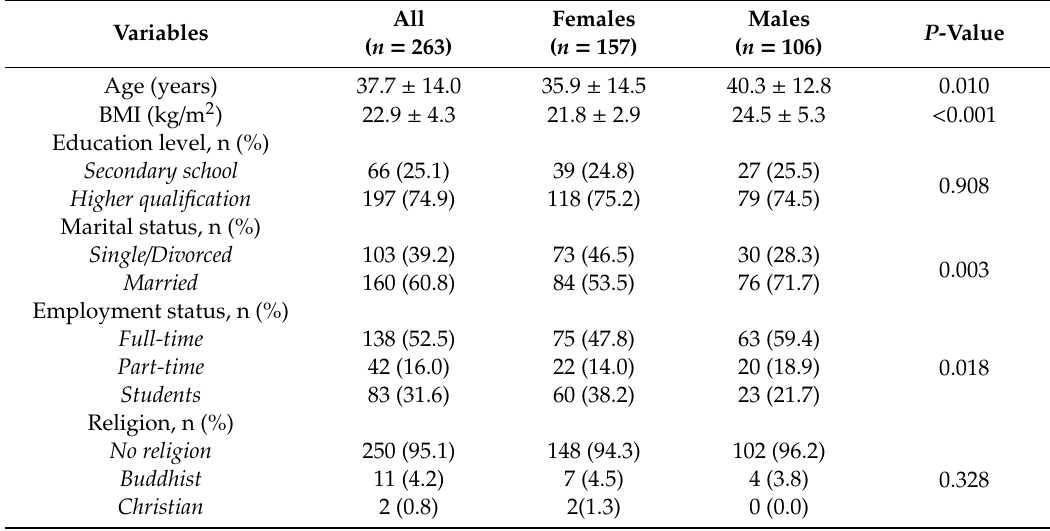
Table 1. Sociodemographic characteristics of participants.